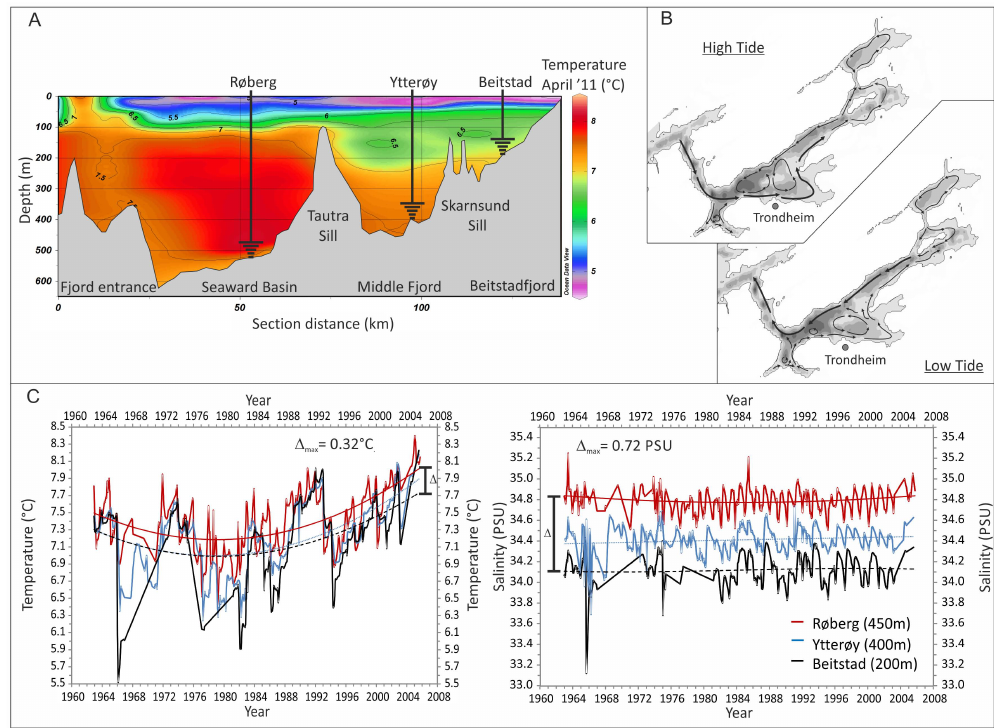
Fig. 2. (A) Water column temperature structure along the fjord axis in April 2011 based on CTD measurements conducted during the sampling cruise of the RV FF Seisma ; (B) simplified pattern of the surface circulation during high tide and low tide (after Jacobson, 1983); (C) bottom water temperatures and salinities measured at the fixed mooring stations Røberg, Ytterøy and Beitstad in the Trondheimsfjord from 1963 to 2005 (data from Trondheim Biological Station of the Norwegian University of Science and Technology (NTNU) in Trondheim: